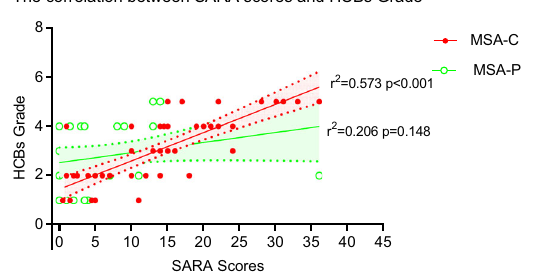
Fig. 1 The Scatter plot showed the correlation between SARA sum score and HCBs grade. Each dot represented on case. The red solid dot represented case in MSA-C group and the green hollow dot represented case in MSA-P group. 95% con fi dential interval (CI) was shown in shadow area.